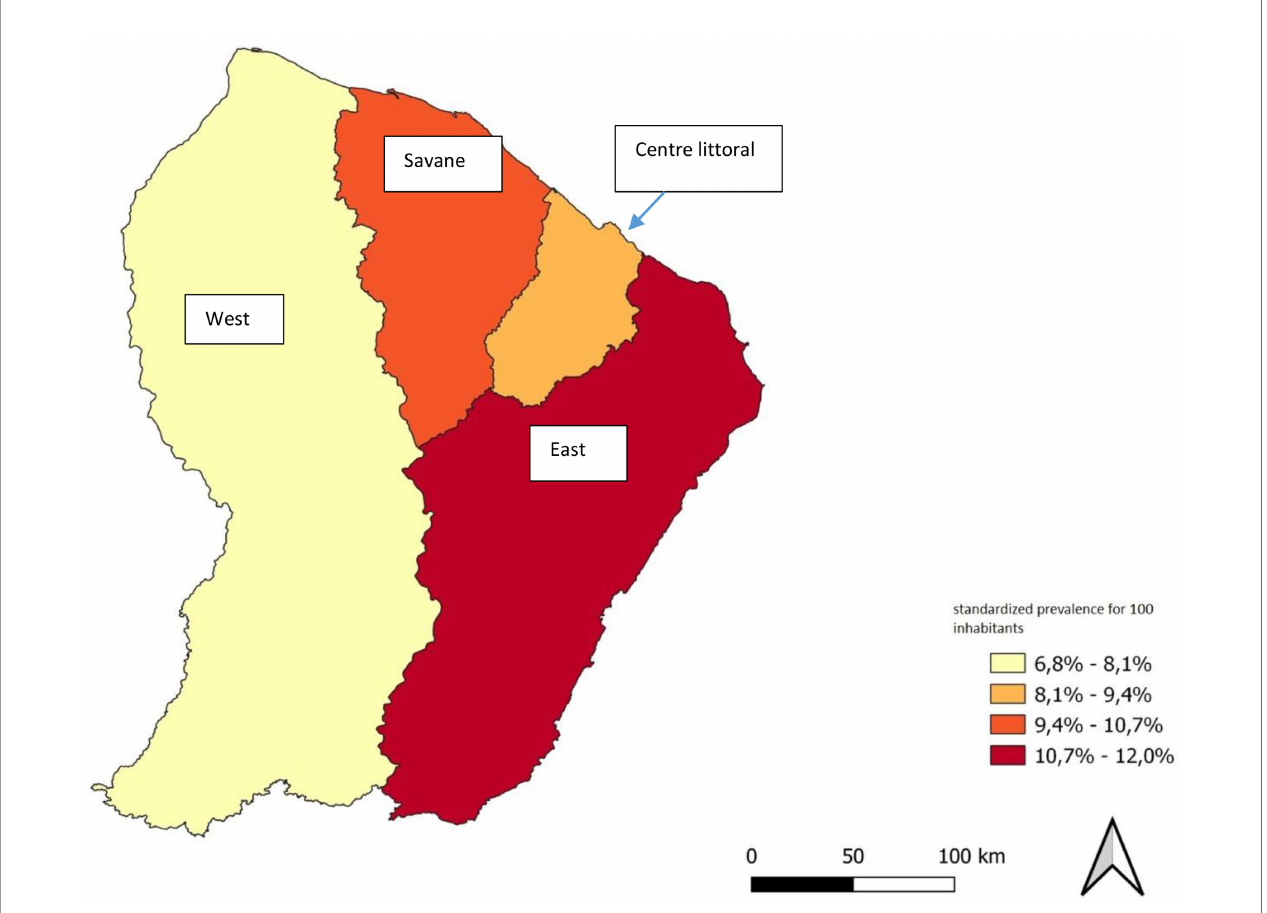
FIGURE 2 | Map of the prevalence of diabetes in French Guiana according to the zones of the